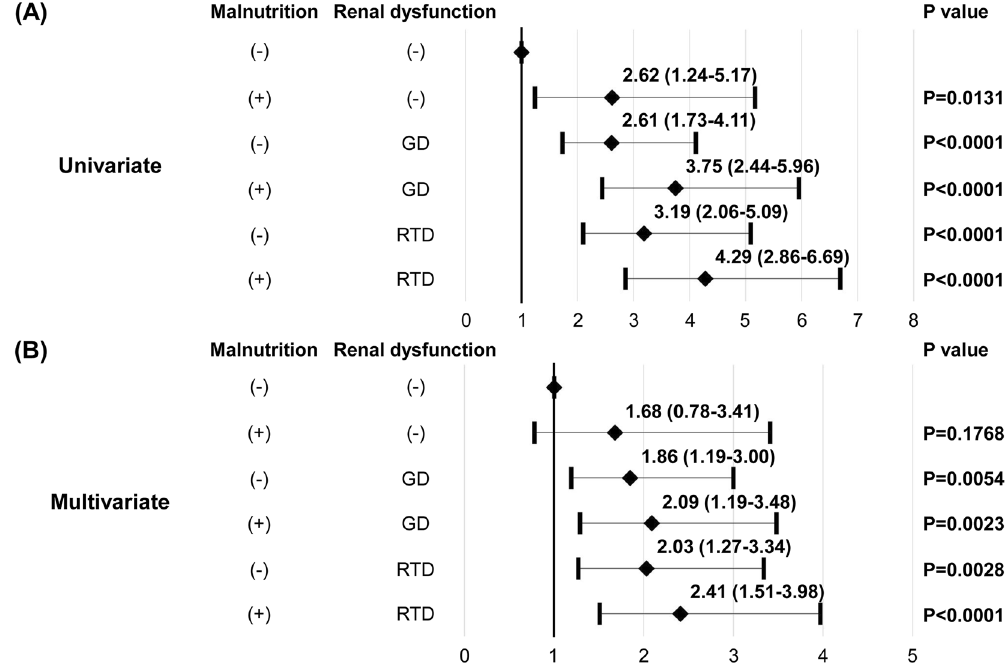
Figure 6. Hazard ratios of malnutrition, GD, malnutrition and GD, RTD, and malnutrition and RTD compared with normal nutritional status and renal function in the univariate ( A ) and multivariate ( B ) Cox proportional hazard regression analysis. Multivariate Cox proportional hazard regression analysis was adjusted for age, sex, NYHA functional class, brain natriuretic peptide, high-sensitivity C-reactive protein and diuretics use. GD glomerular damage, NYHA New York Heart Association, RTD renal tubular